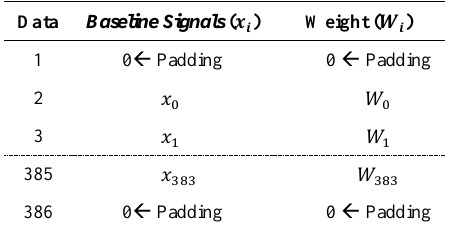
Table 2. Illustration of the padding process in the baseline EEG signal